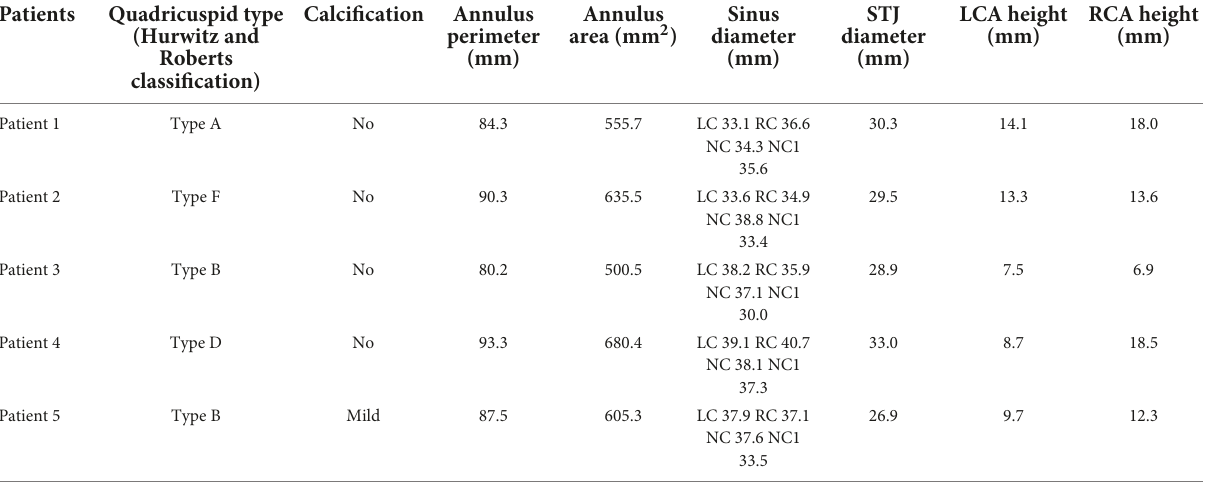
TABLE 2 Preoperative computed tomography (CT)